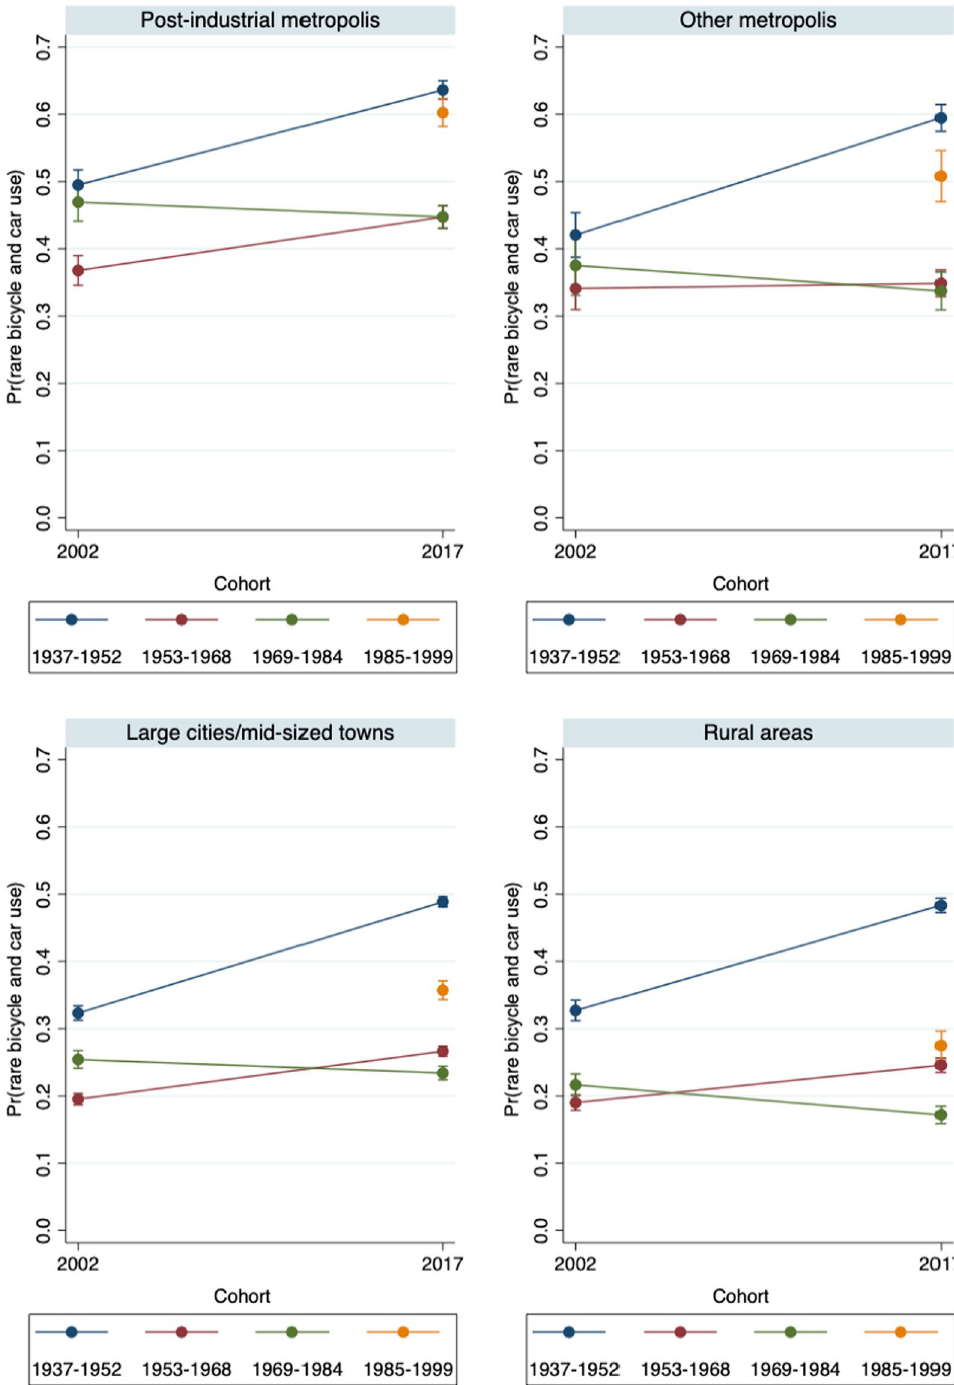
Fig. 4 Predicted probabilities of rare bicycle and car use in 2002 and 2017 – by settlement type (Model 1). Source: Mobility in Germany: MiD person-time-series dataset (own calculations). Note: Rare bicycle and car use is defined as bicycle use of at most 1 to 3 times per week and car use of at most 1 to 3 times per week. Survey weights are applied. See also Table 6 for main effects and standard